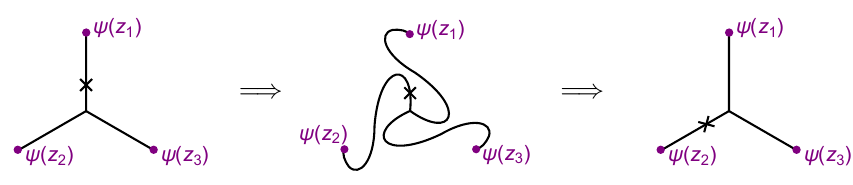
Figure 27 . Moving the defect operators (cid:9)( z 1 ) ; (cid:9)( z 2 ) ; (cid:9)( z 3 ) cyclically and then rotating each (cid:9) by 2 (cid:25) have the same net e(cid:11)ect as the cyclic permutation map on the T-junction, which amounts to 3 relabeling the last leg at the junction (marked by \ (cid:2)